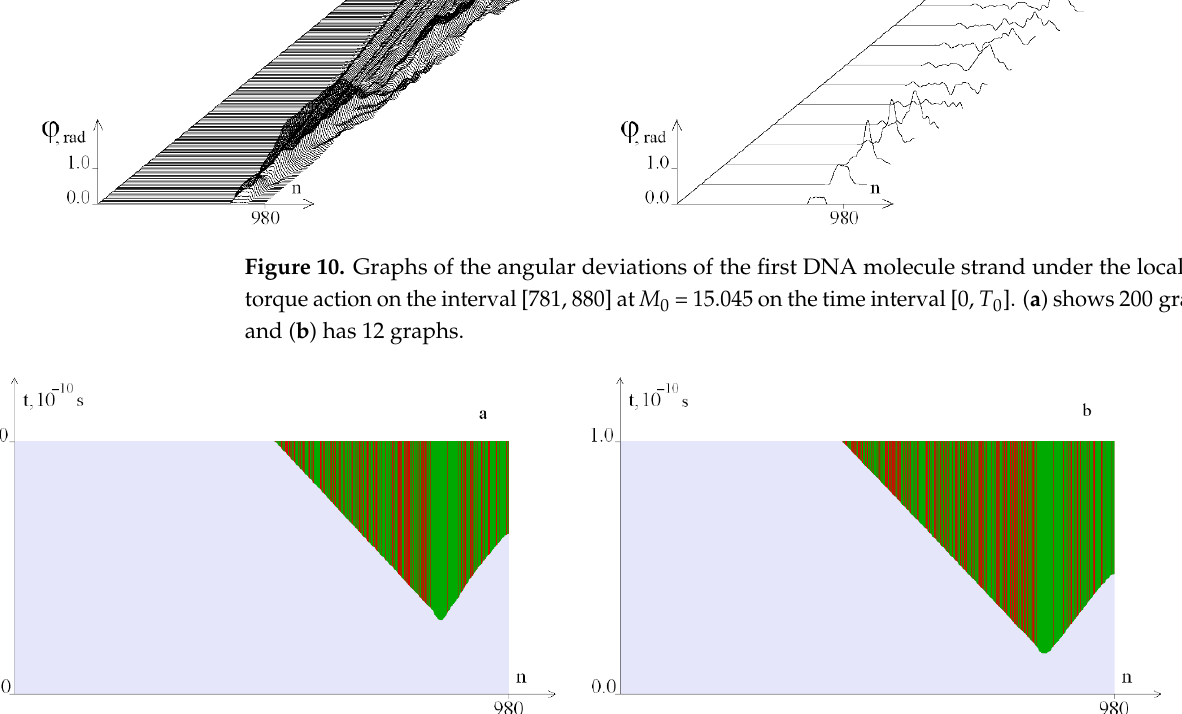
strand under the localized torque action on the segment [781, 880] at M 0 = 15.045, at which OS does not yet occur.